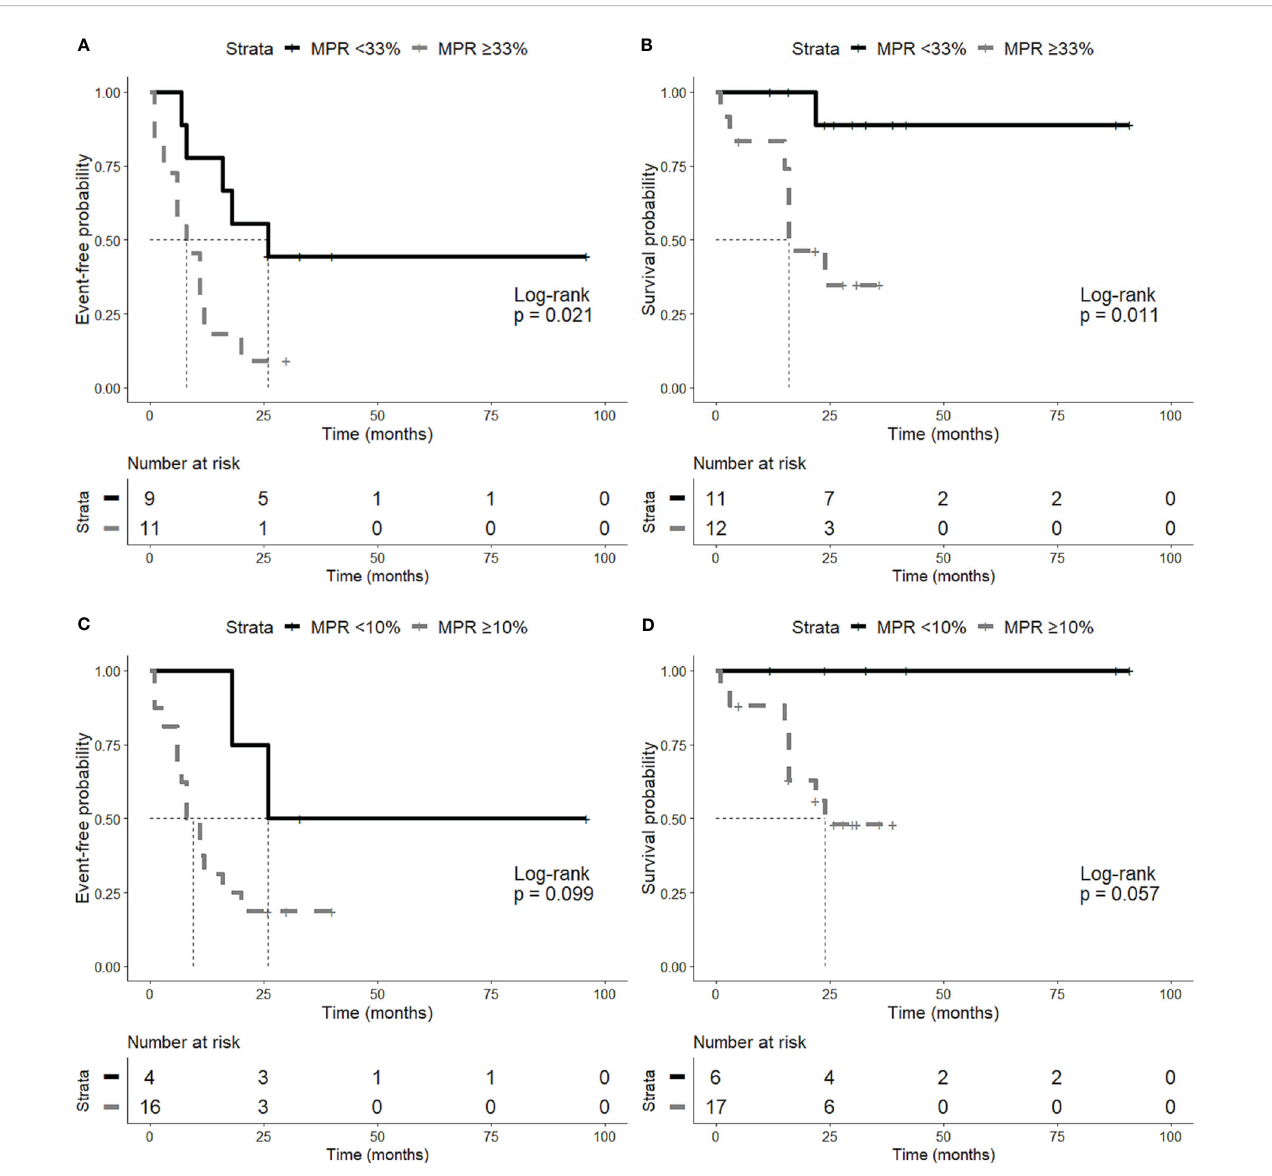
FIGURE 5 Time-to-event analyses. Patients were strati fi ed according to the best cut-off of major pathological response (MPR) (i.e., 33% of viable tumor cells). Patients with less than 33% of viable tumor cells showed a better event-free survival (EFS) (A) and overall survival (OS) (B) . The classic 10% MPR cut-off was also tested and showed the same trend both on EFS (C) and OS (D)